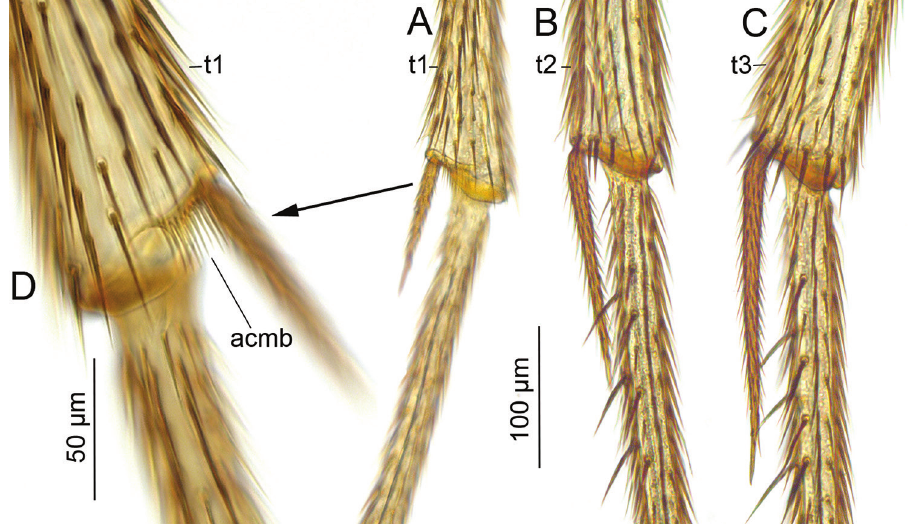
Figure 6. Kibaleana apicospinosa sp. n., apical part of tibia and basal part of first tarsal segment, male. A Fore leg B Mid leg C Hind leg D Fore leg, closer view. Abbreviations: acmb = apical comb of setae; t = fore, mid and hind